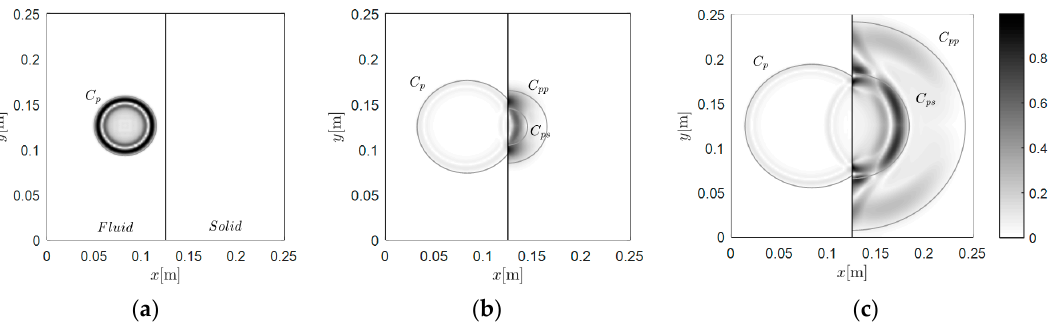
Figure 4. Snapshots of the wavefield induced by the source at 0.083 m and 0.125 m in the fluid region: ( a ) 25 μ s, ( b ) 37.5 μ s, and ( c ) 50 μ s.